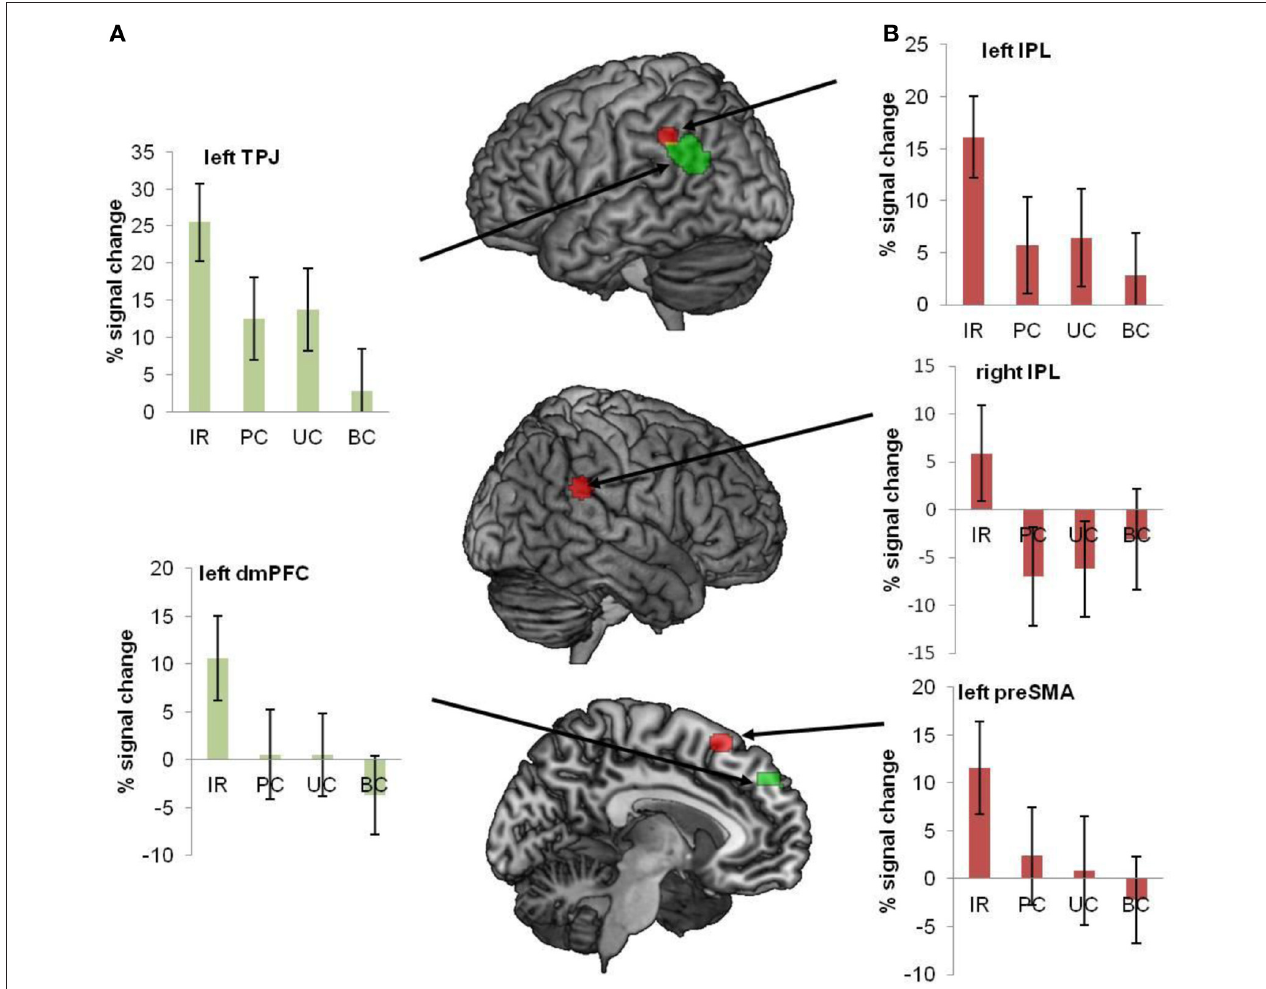
FIGURE 11 | Regions of interest were interrogated with respect to the conditions IR, PC, UC, and BC. The image shows all ROI’s, superimposed on a brain template. The bar diagrams illustrate mean percent signal change for each condition. The error bars depict the